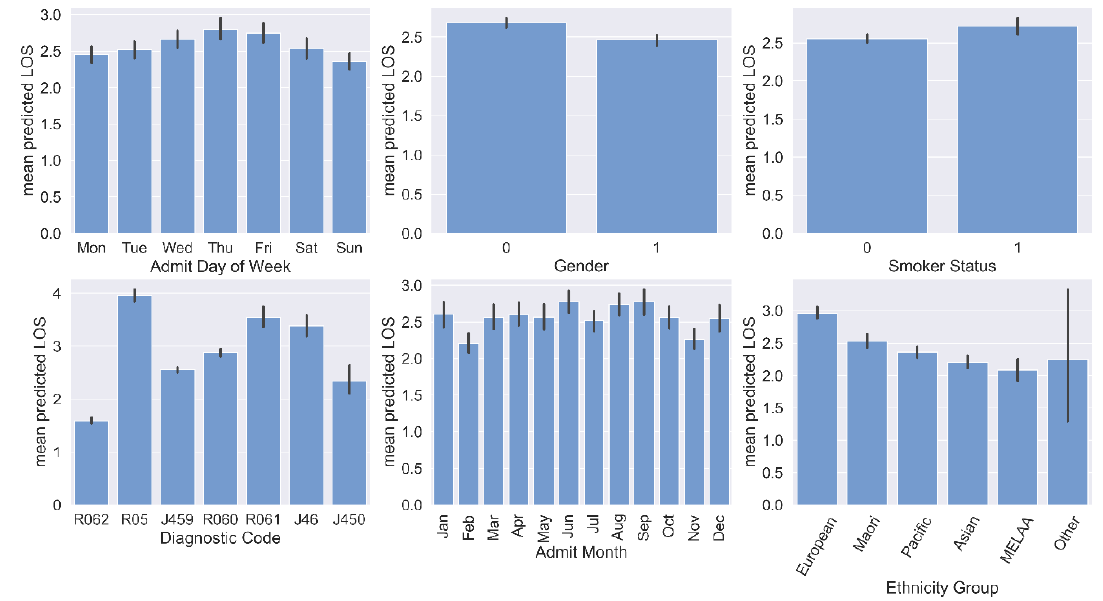
Figure 8. Mean predicted LOS for different feature values.